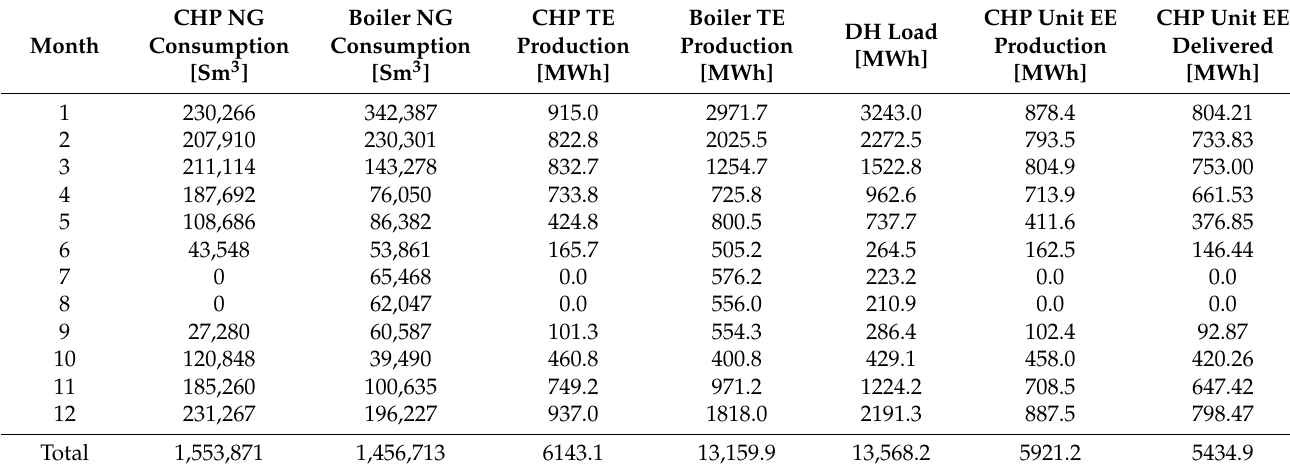
Table 5. Monthly operational data/performance parameters of the CHP unit (year 2019).